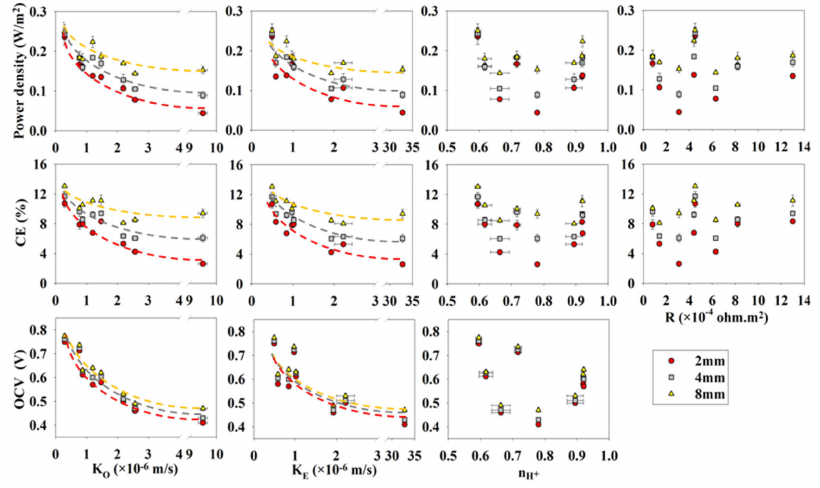
Figure 1. Performance of the 2, 4 and 8 mm FPMFCs versus the separator